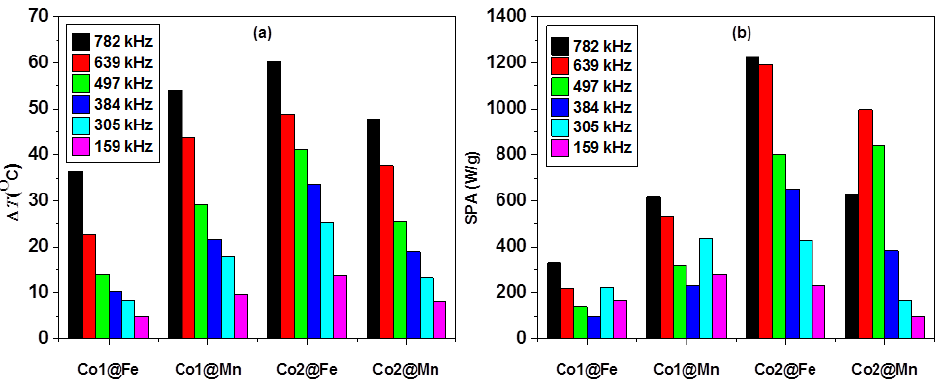
Figure 5. Variation of ∆ T ( a ) and SPA ( b ) at frequencies indicated on legends and field amplitude of 31.6